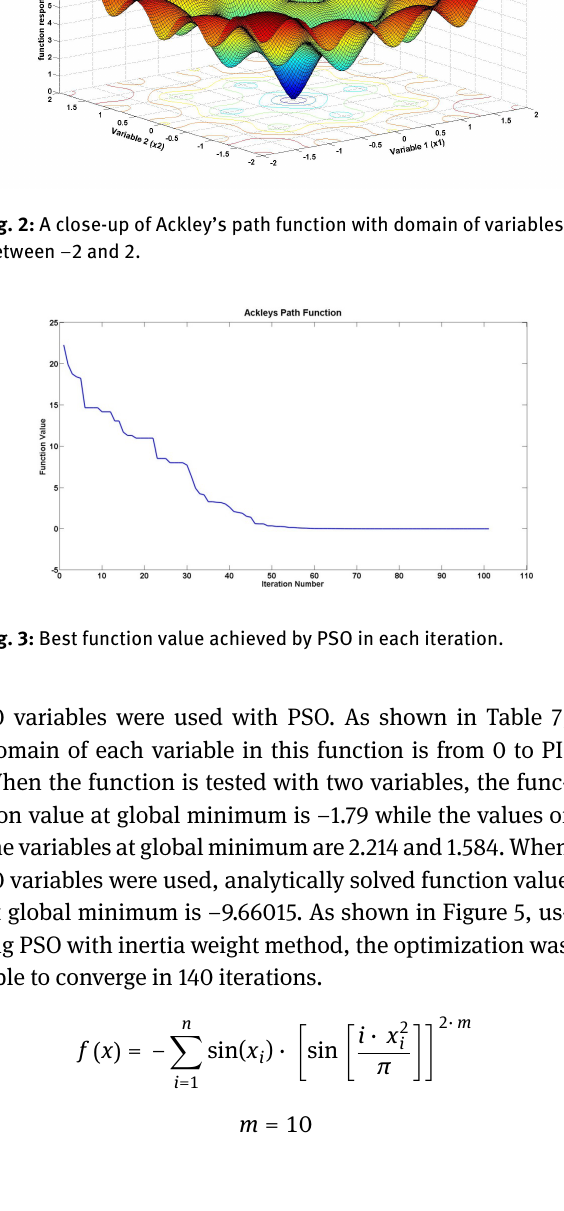
Table 3: Ranges of variables and global minimum for Ackley’s Path Function.